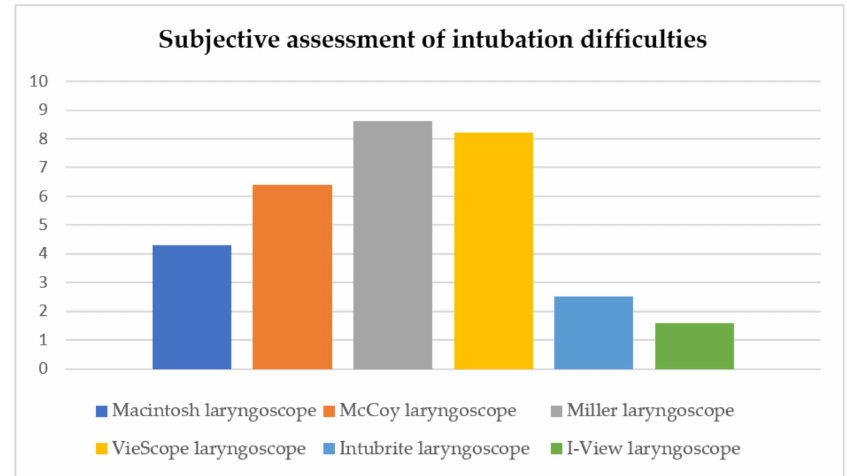
Figure 5. The feelings of the respondents (0—no difficulties; 10—maximum